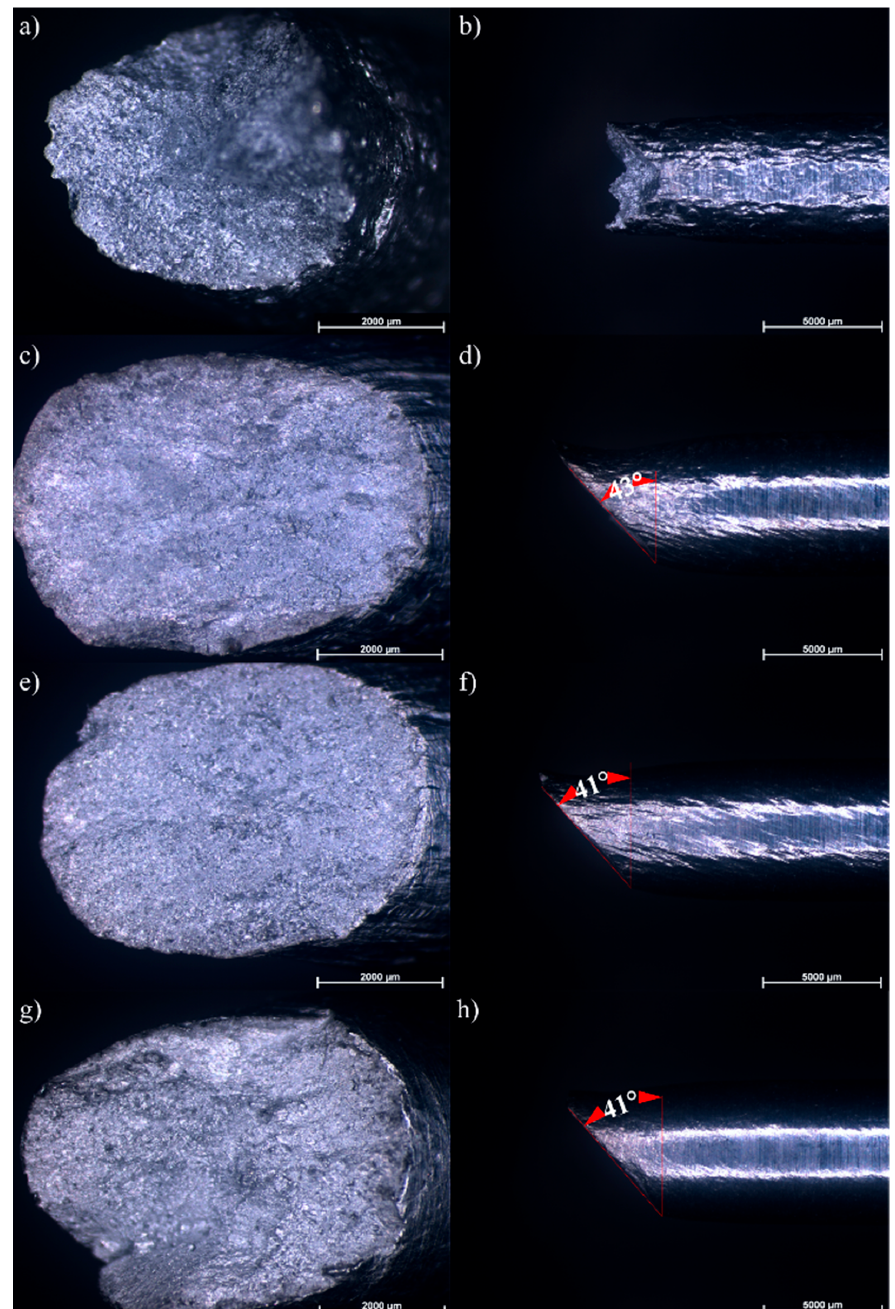
Figure 10. Fracture surfaces of as-built vertical and horizontal samples: ( a ) and ( b ) solution-treated (ST); ( c ) and ( d ) ST + ECAP 2×; ( e ) and ( f ) ST + ECAP 2× + ageing 160 °C for 4 h; and ( g ) and ( h ) ST + ECAP 2× + ageing 180 °C for 4 h.